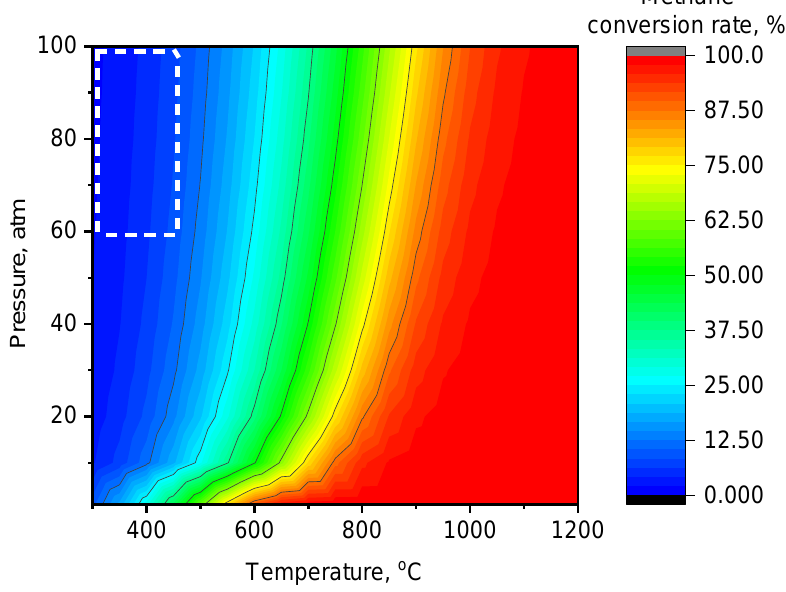
Figure 3. The dependence of methane conversion rate on temperature and pressure at constant steam/methane ratio equals 5 as a result of thermodynamic calculations for the primary catalytic SMR (steam methane reforming) SMR (steam methane reforming) process.